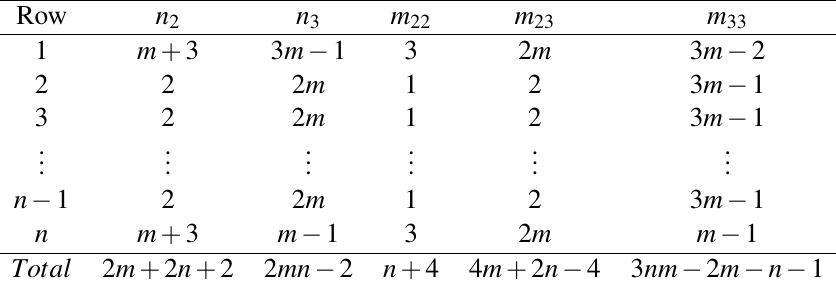
Table 1 Vertex and edge partitions of graphene sheet for n (cid:54) = 1